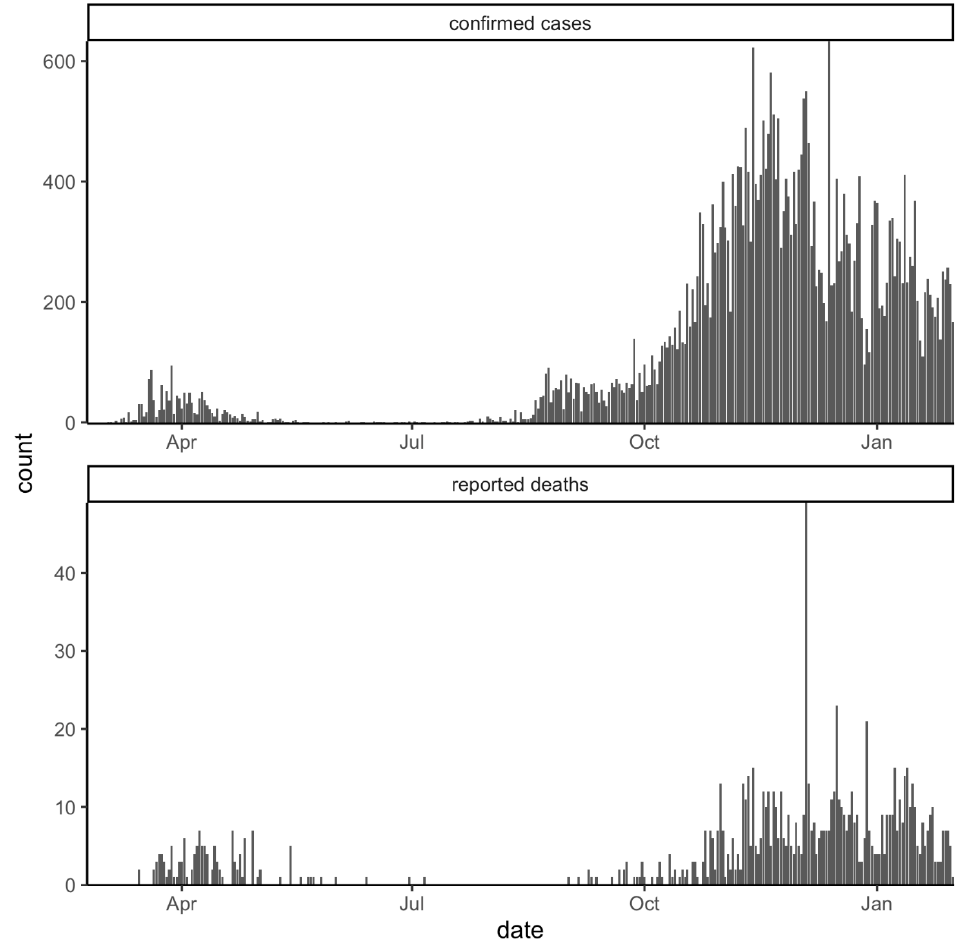
Figure 2. Daily Sardinian COVID-19 confirmed cases and reported deaths.